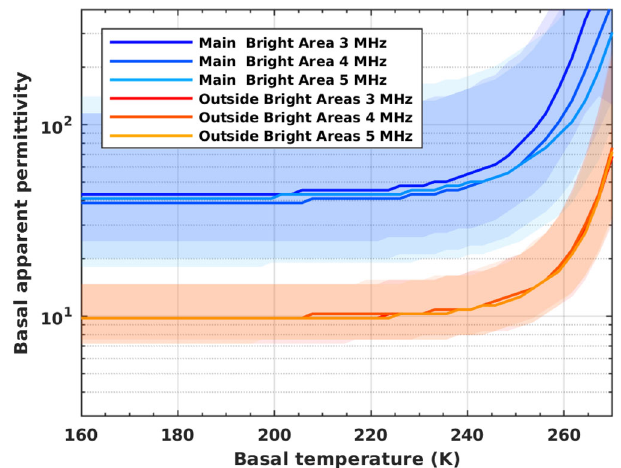
Fig. 5 | Apparent basal permittivity inside and outside the bright area as a function of basal temperature. Solid color lines are the median values at three frequencies, and the color bands indicate the 25th (cid:1) 75th percentile range of apparent permittivity values. Above 230K the median values estimated for both areas increase towards very high values.